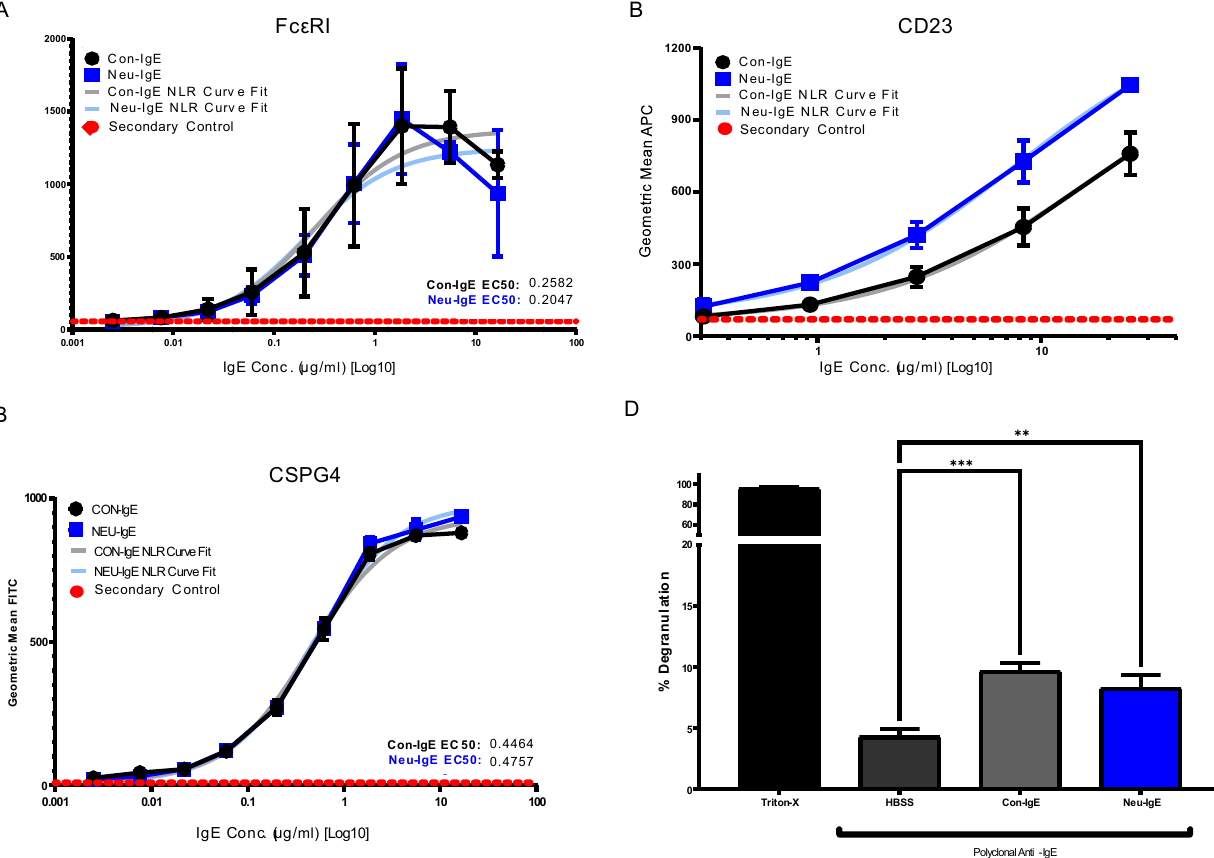
Figure 4. Binding of Neu-IgE and Con-IgE on Fc receptor and target antigen-expressing cells. ( A ). Binding to Fc ε RI-expressing RBL-SX38 cells by Con-IgE and Neu-IgE with EC50, N = 3, error bars = SD; ( B ). Binding to CD23-expressing RPMI-8866 cells by Con-IgE and Neu-IgE, N = 3, error bars = SD; ( C ). Binding to CSPG4-expressing (target antigen) A2058 cells by Con-IgE and Neu-IgE with EC50, N = 3, error bars = SD; ( D ). Degranulation of RBL-SX38 cells. Data represent the mean ± SEM of 9 independent experiments. ** p < 0.01, *** p ≤ 0.001.